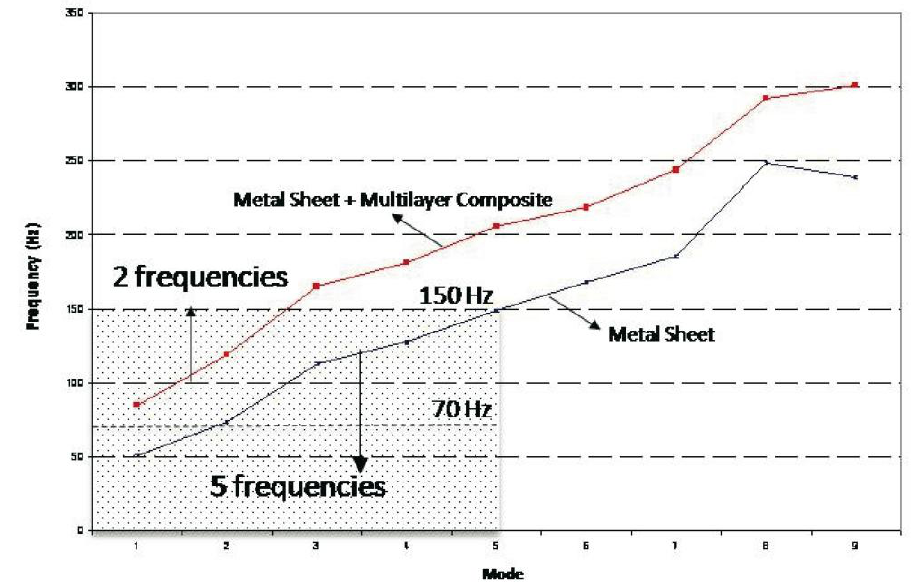
Figure 8. Modes: Naked Metal Sheet vs. Metal Sheet plus Lightweight Multilayer